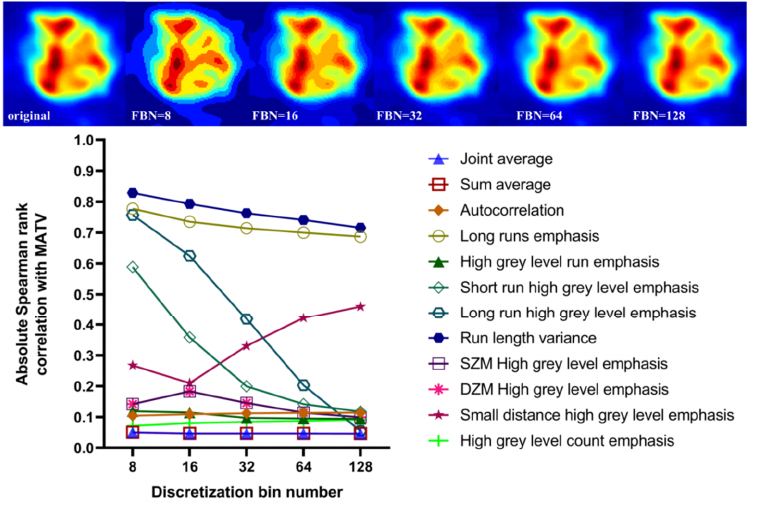
Figure 10. Correlation between features with excellent robustness and MATV from: original SUV image discretized with FBN from 8 to 128.